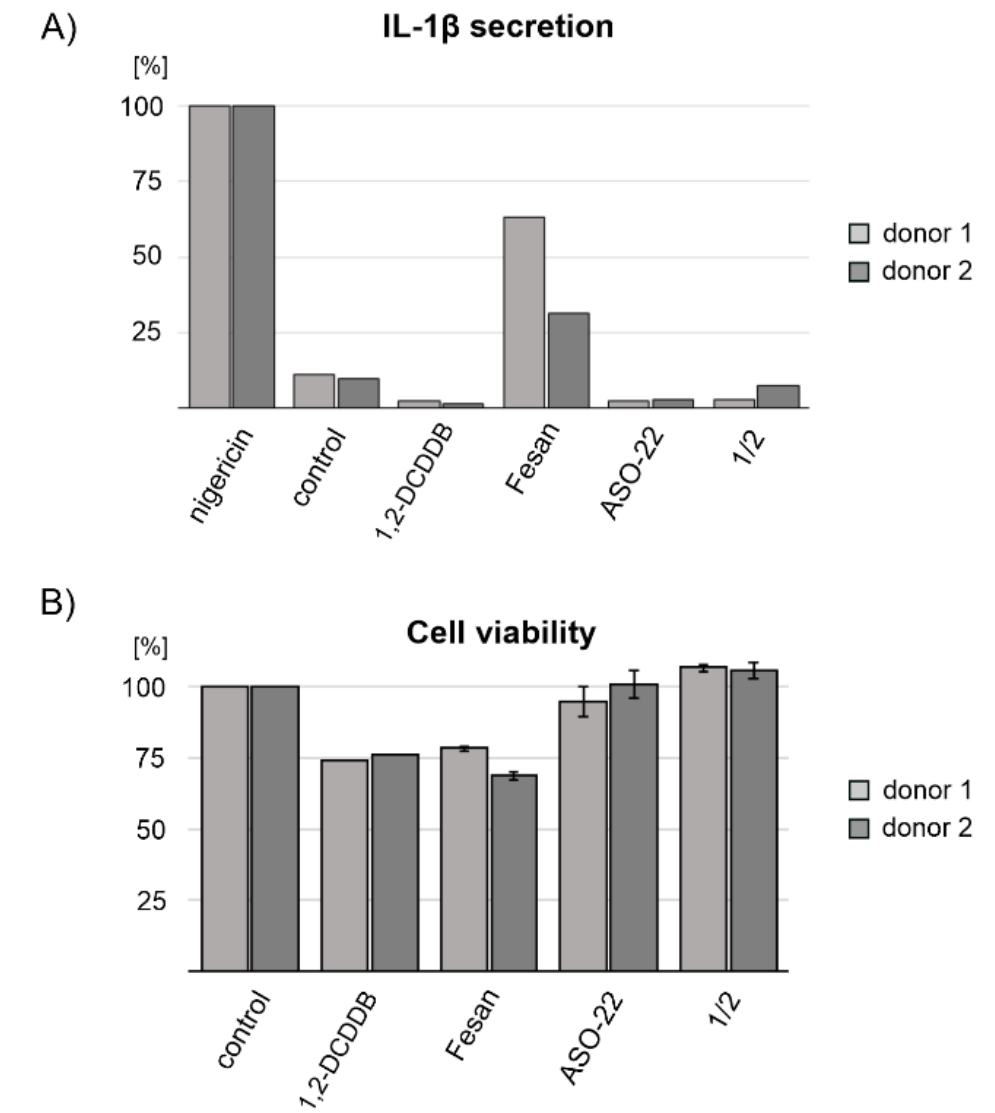
Figure 7. Secreted IL-1 β levels ( A ) and cell viability assay ( B ) of human primary monocyte-derived macrophages obtained from two donors (1 and 2) upon transfection with nanostructures 1 / 2 or oligonucleotide ASO-22 or treatment with boron clusters 1,2-dicarba- closo -dodecaborane (1,2- DCDDB) and FESAN. For IL-1 β ELISA, LPS-primed human primary monocyte-derived macrophages were stimulated with the tested compounds at a concentration of 1 µ g/mL. Non-stimulated cells were used as a control. As a positive control for IL-1 β release, cells were stimulated with nigericin, and the level of IL-1 β secretion for the test compounds was expressed as that of nigericin-induced IL-1 β . The viability of cells was determined by the MTT assay. ± SD is given for two technical repeats.